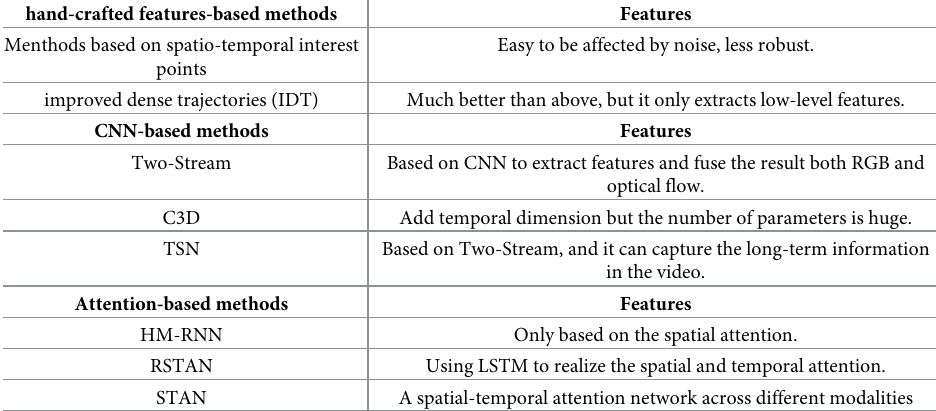
Table 1. The summary of the related works. hand-crafted features-based